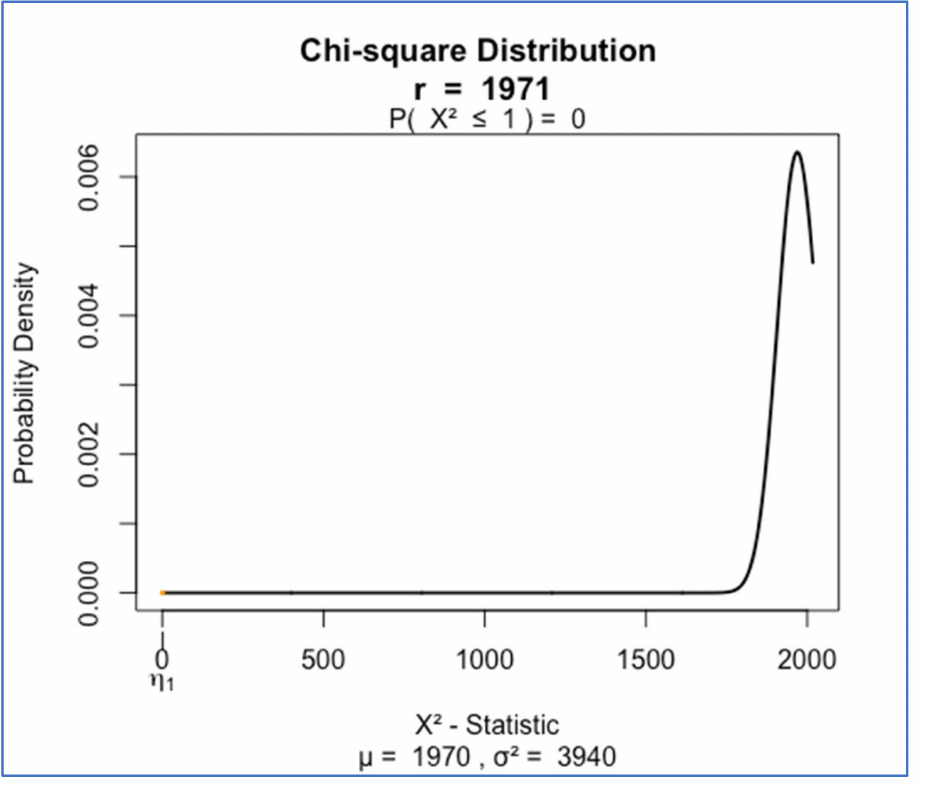
Figure 12. Chi-square